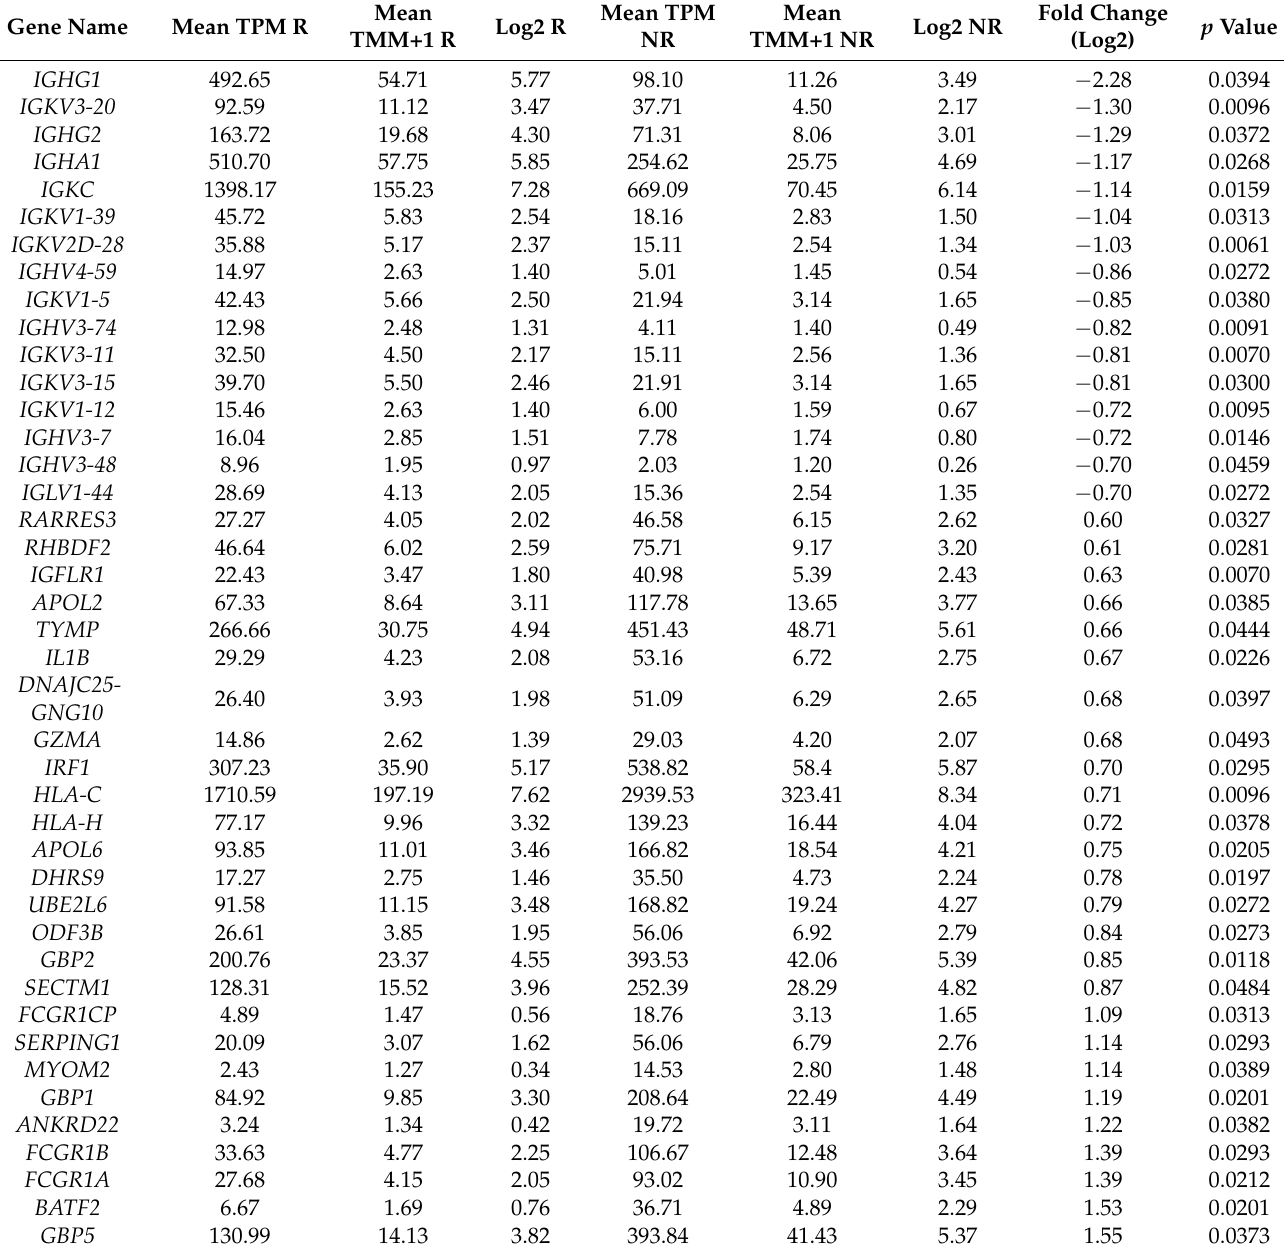
Table 4. List of genes expressed differentially between responders (R) and non-responders (NR) after two weeks of anti-TNF treatment.